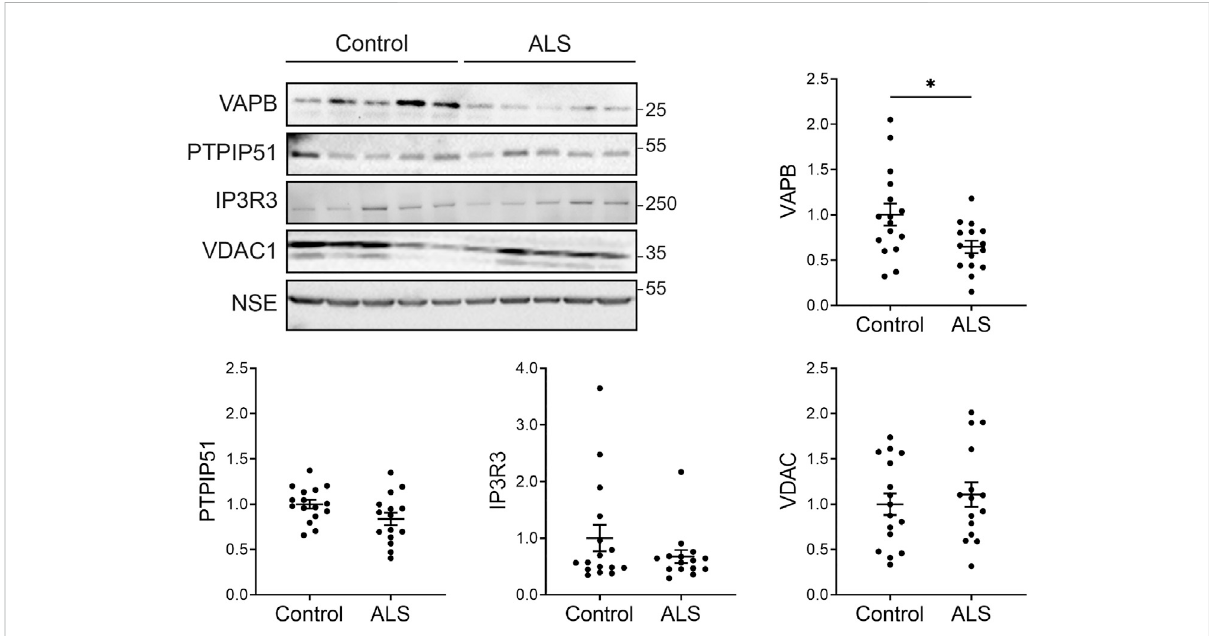
FIGURE 1 Expression of VAPB, PTPIP51, IP3 receptor type-3 and VDAC1 proteins in post-mortem control and ALS spinal cords. Representative immunoblots are shown. Graphs show quanti fi cation of protein levels in the different samples following normalisation to NSE levels in the same sample. N = 16 control and 15 ALS cases. Data were analysed by unpaired t -test. Error bars are standard error of means (s.e.m.); * p <